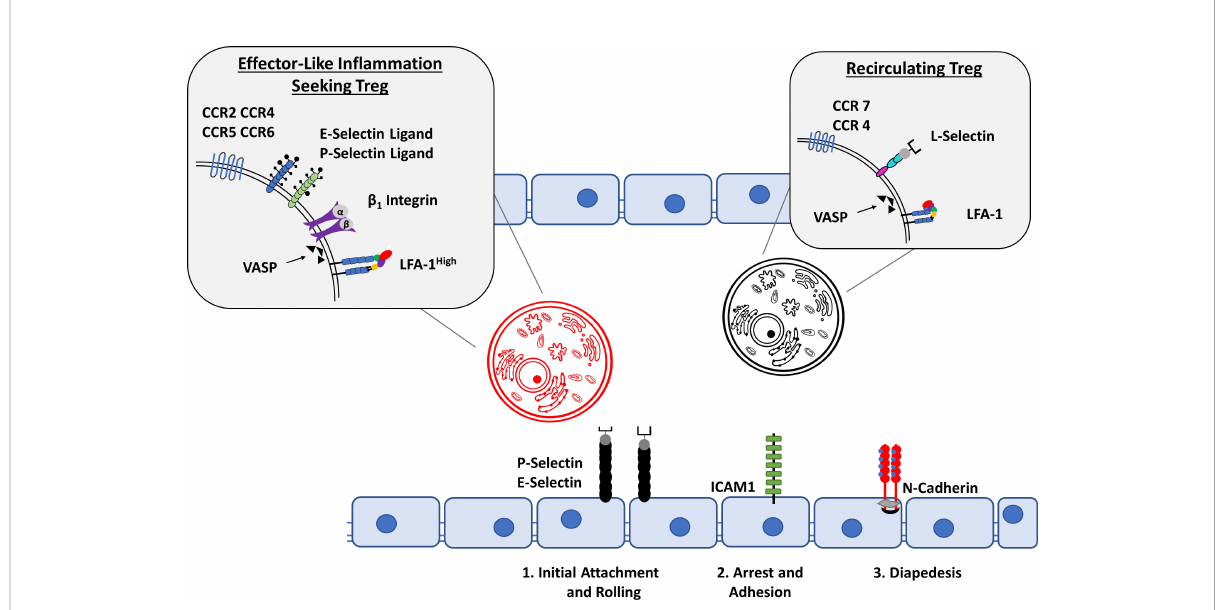
FIGURE 4 Treg cell migration into in fl ammatory sites. A dysregulation of Treg migration has been implicated in the pathogenesis of RA. Depending on the expression of cell-surface molecules, Tregs can be divided into recirculating Tregs and in fl ammation seeking Tregs. In contrast to the expression of CCR7, CCR4, L-Selectin and LFA-1 in a low-af fi nity state allows recirculating Tregs to remain in the bloodstream, activated in fl ammation seeking Tregs are able to migrate to their sites of action through the expression of E- and P- selectin Ligands, CCR2, CCR4, CCR5, CCR6, b 1 Integrin as well as LFA-1 in a high af fi nity state. The Interaction with P- and E- selectin, ICAM1 and N-Cadherin among other molecules on the activated endothelium allows for the classical steps of cellular migration: Initial attachment and rolling, followed by arrest and adhesion which eventually leads to cellular diapedesis (14,